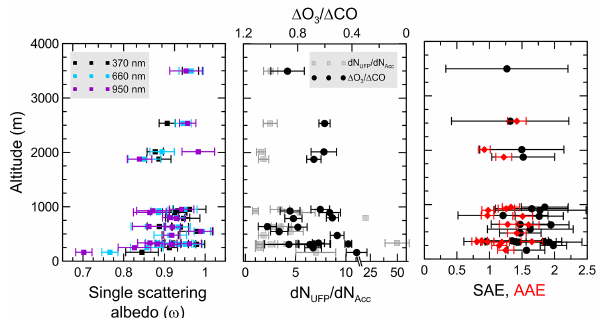
Figure 6. Single scattering albedo (370, 660, and 950nm), ozone enhancement factor ( (cid:49) O 3 /(cid:49) CO), ultrafine-to-accumulation ratio (d N UFP / d N Acc ) , and scattering (SAE) and absorption Ångström exponent (AAE) versus height for all analysed SLRs cases. Uncer- tainties on measured and retrieved quantities (horizontal bars) are also shown in the